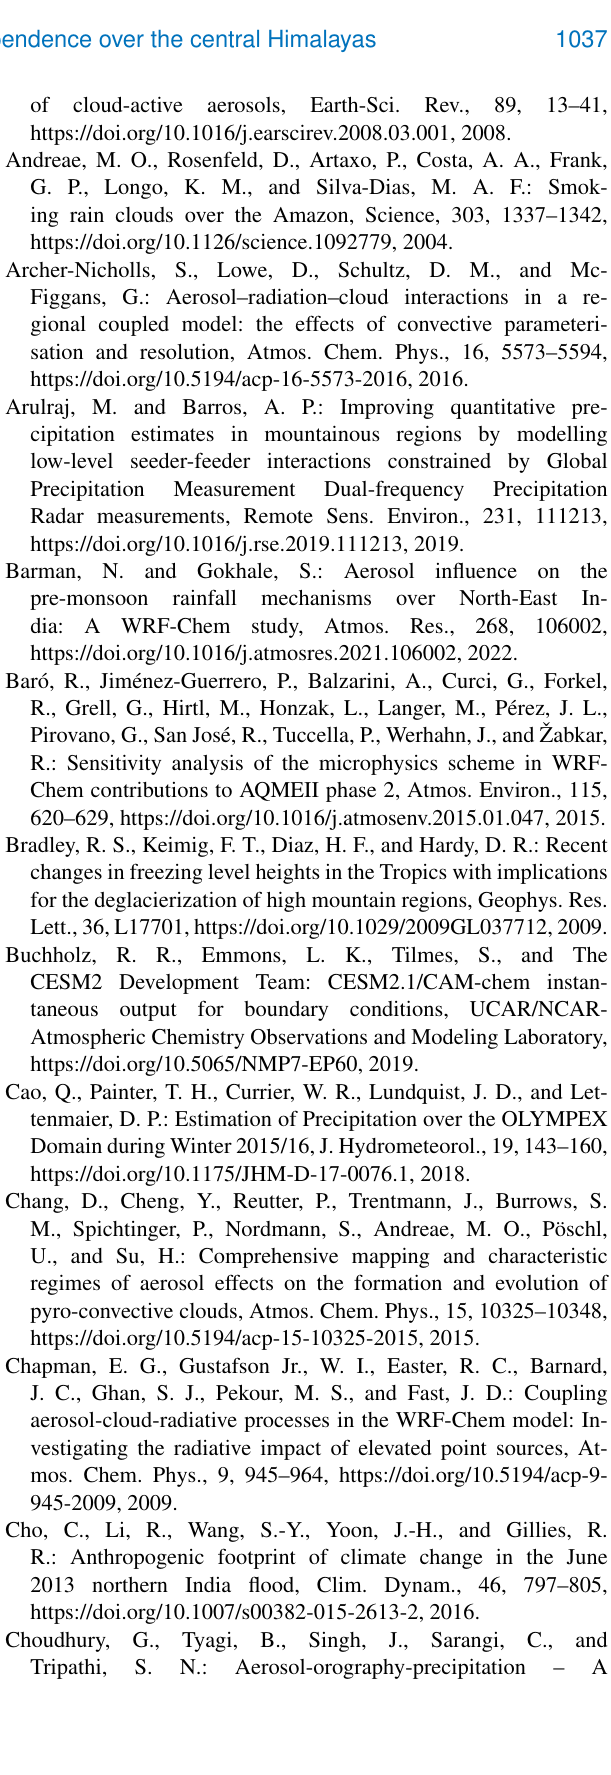
Figgans, G.: Aerosol–radiation–cloud interactions in a